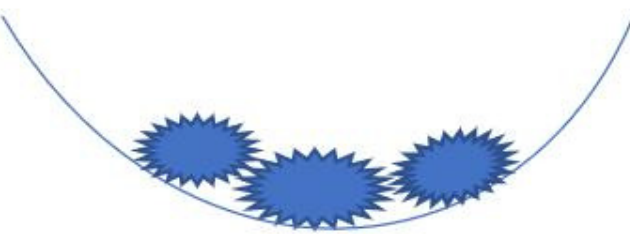
Figure 13. Surface roughness limits particle proximity.